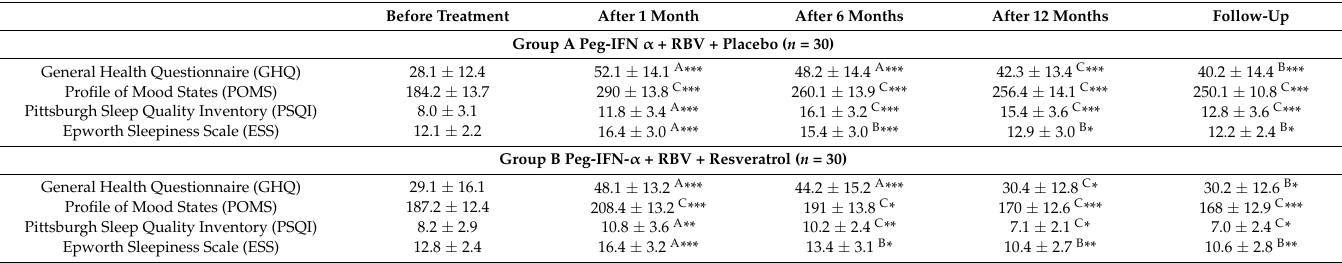
Table 3. Scores of General Healt Questionnaire (GHQ), Profile of Mood States (POMS), Pittsburgh Sleep Quality Inventory (PSQI) and Epworth Sleepiness Scale (ESS) in the study groups. Values are expressed as Mean ± SD.